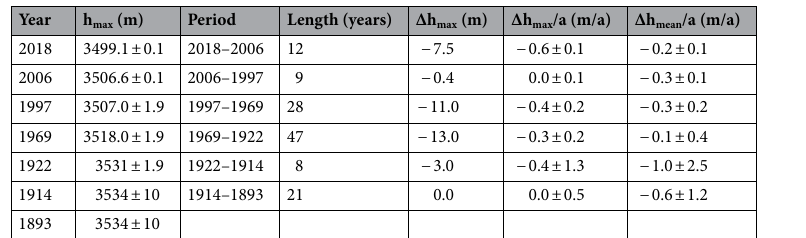
Table 2. Maximum elevation (h max ) of the summit Weißseespitze from DEMs and historical maps 27,34–37 , as well as the mean thickness change h mean (Fig. 3, Table S2) in total and per